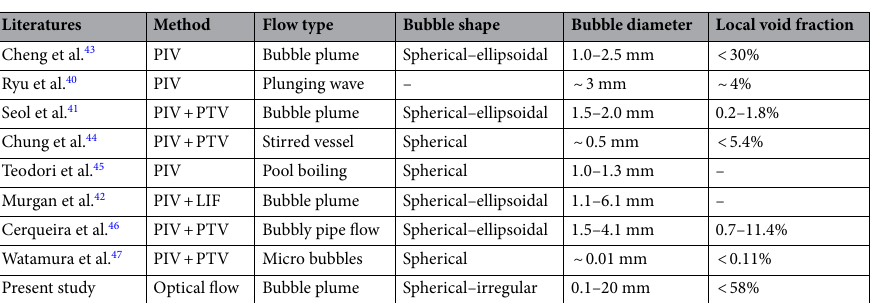
Table 2. Comparison of the tested conditions for measuring the bubble velocities in the bubbly flow using the PIV and/or